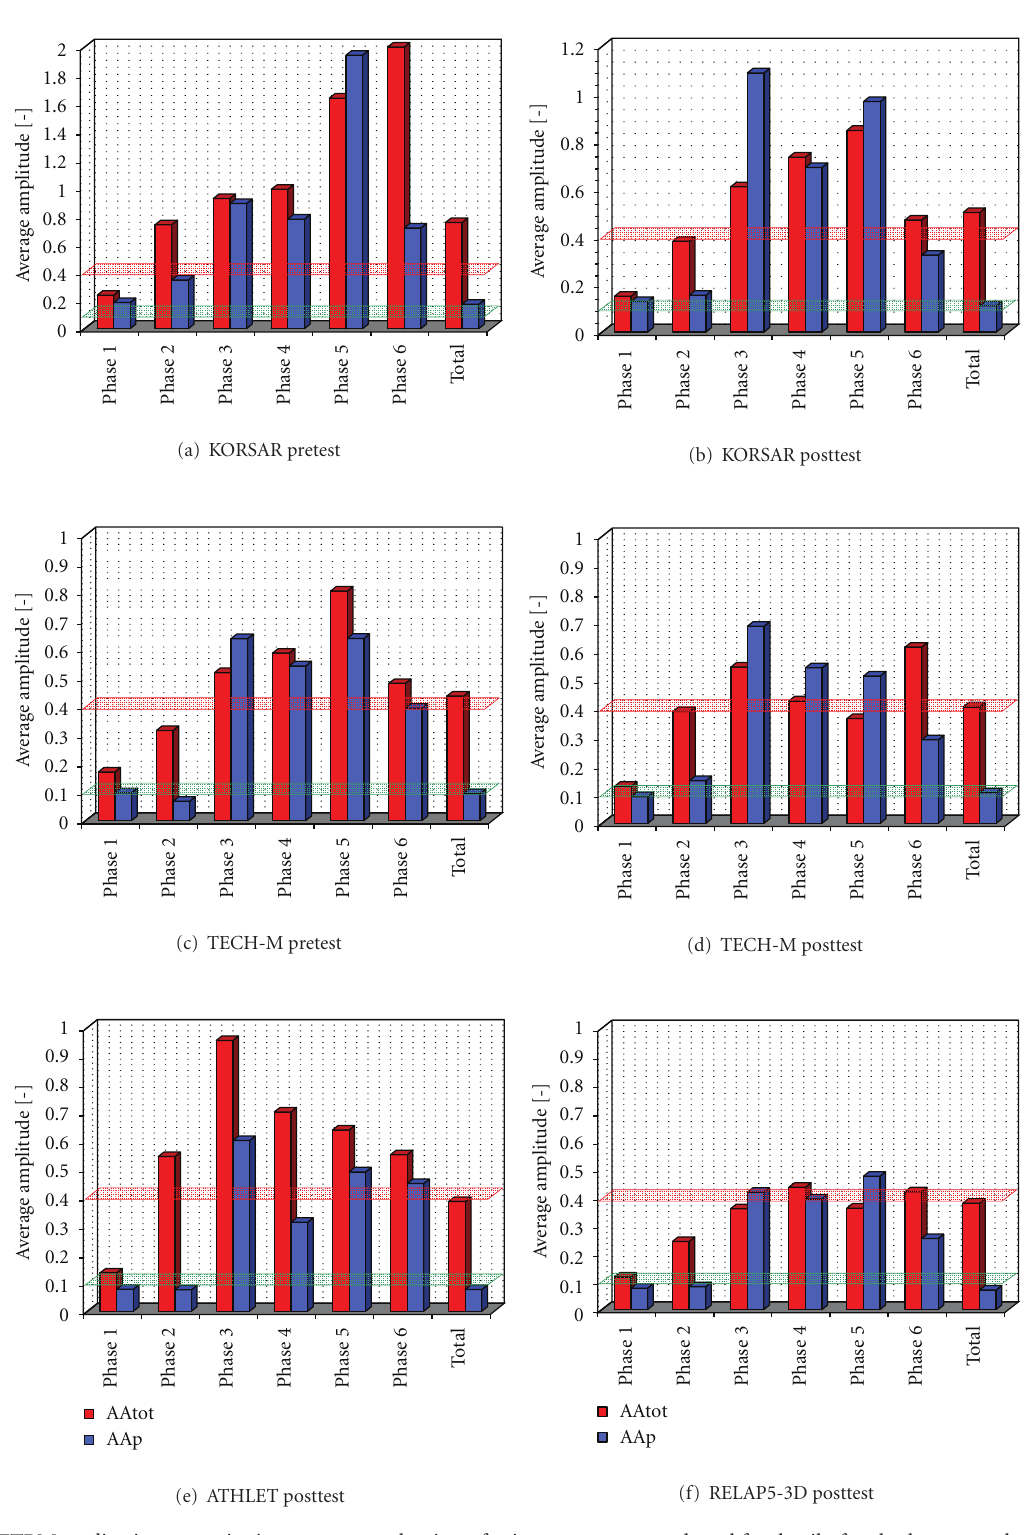
Figure 7: FFTBM application: quantitative accuracy evaluation of primary pressure, and total for detail of each phenomenological window and overall